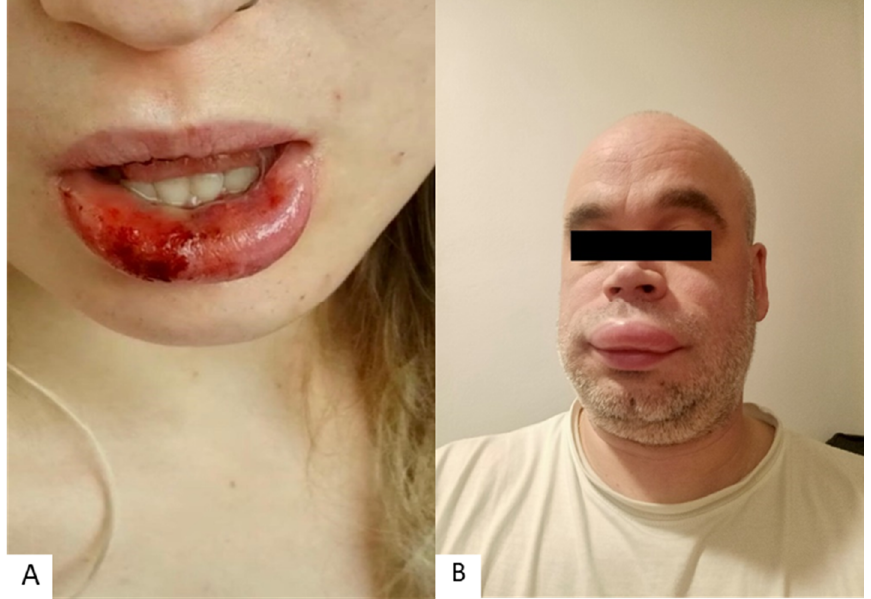
Figure 3. Erythema multiforme on the lip ( A ) and angioedema of the upper lip ( B ); (cheilitis connected to dermatologic/systemic diseases).